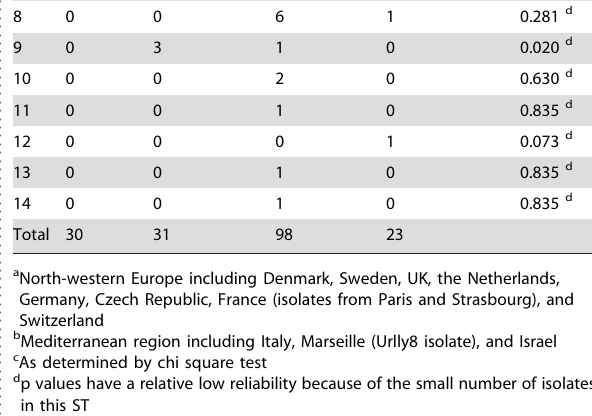
compared with their frequency in the whole panel by using Fisher’s exact test. Human-derived isolates were over proportion- ally allocated to ST1 and under proportionally associated with ST7 (p # 0.001). The other major STs did not show a disproportional distribution pattern (Table 3).